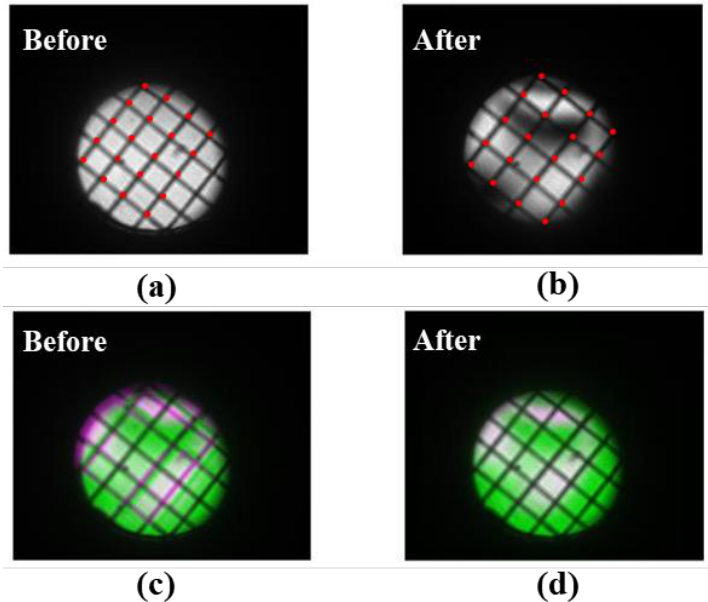
Figure 3. Results of the correction method. ( a ) Original image without pressure; ( b ) distorted images with 120 MPa pressure; ( c ) merged image of ( a , b ) with false-color algorithm; ( d ) merged image of original and corrected images with false-color algorithm. Red dots in ( a , b ) are the feature points.